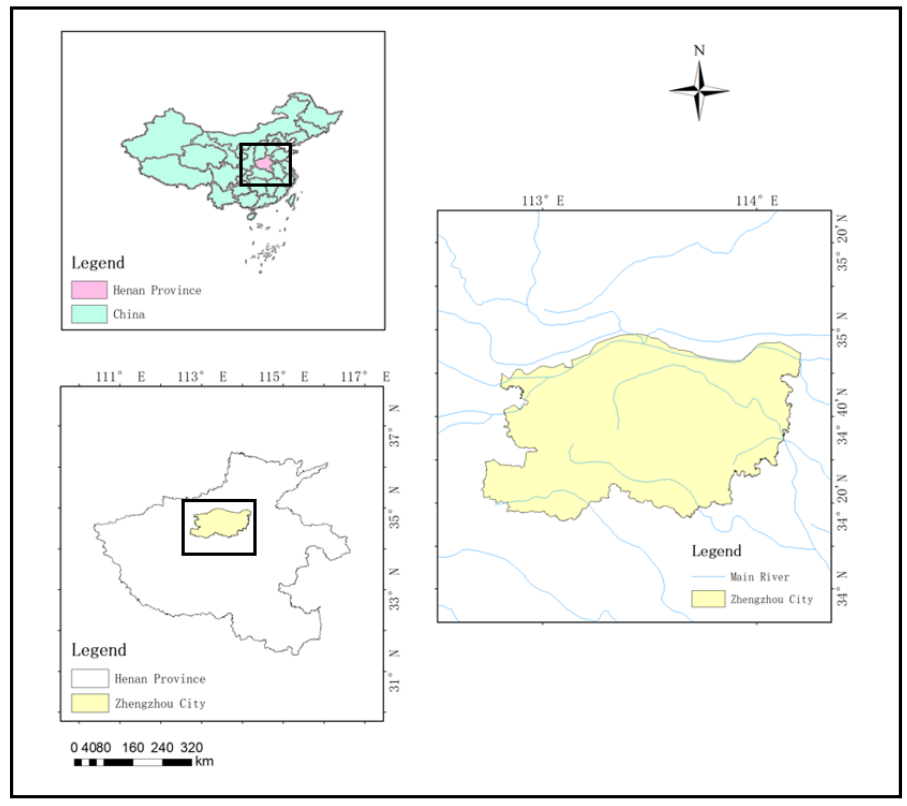
Figure 1. Location of Zhengzhou city.